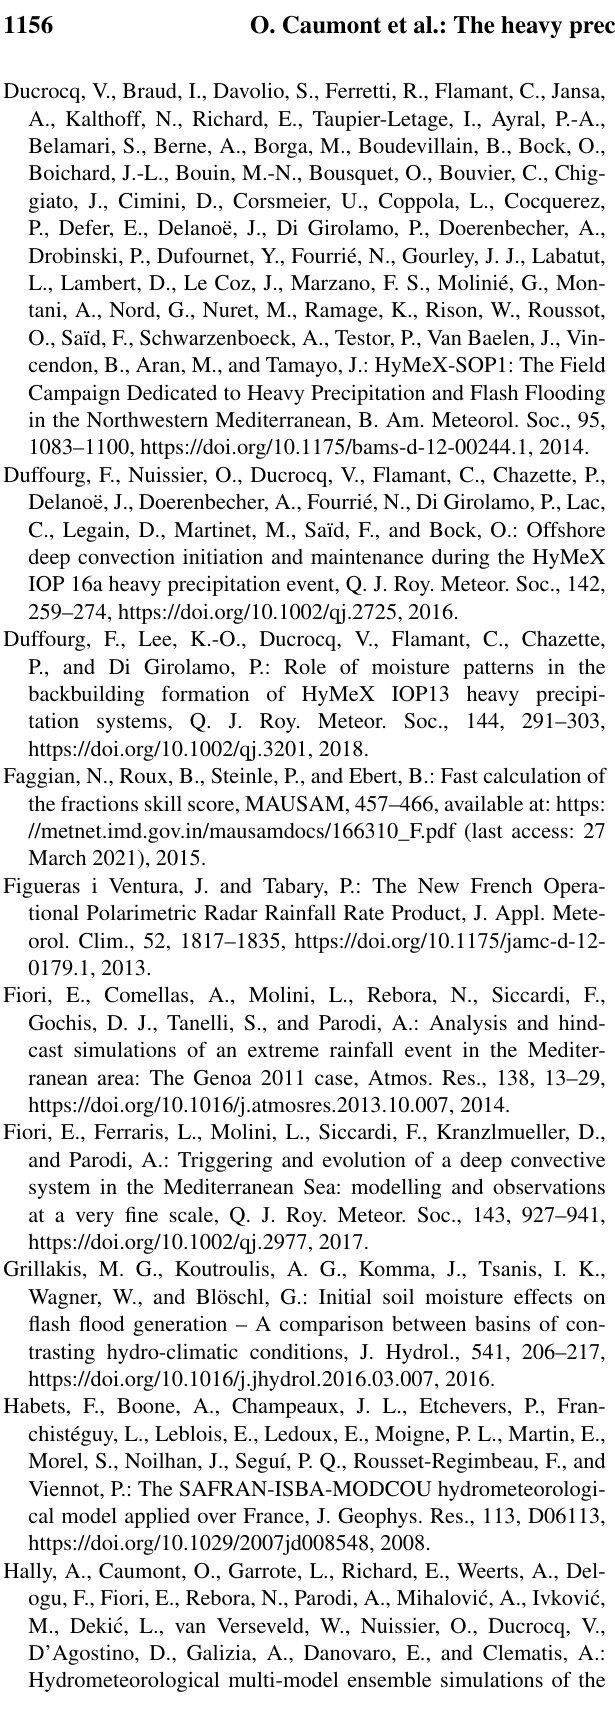
Figueras i Ventura, J. and Tabary, P.: The New French